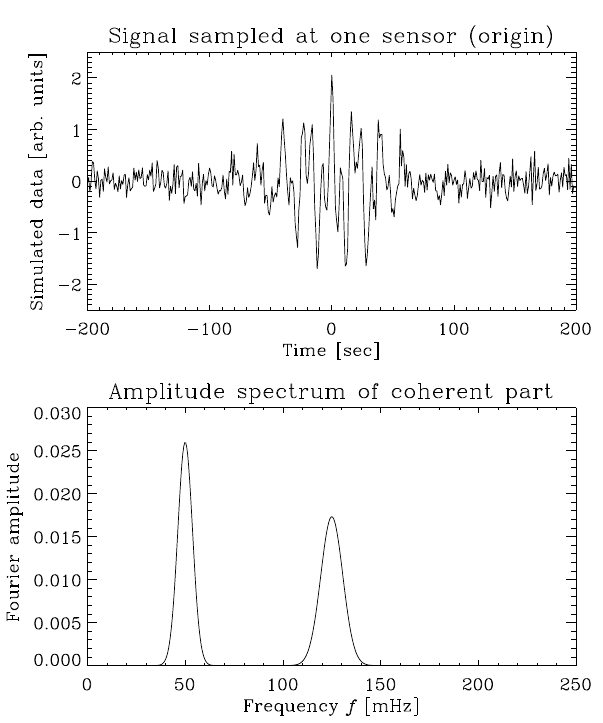
Fig. 1. Demonstration of the wave surveyor technique. Upper panel: Synthetic time series sampled at one of the four points in space. Lower panel: Amplitude spectrum of the coherent part of the model signal as a function of frequency f = ω/ 2 π .